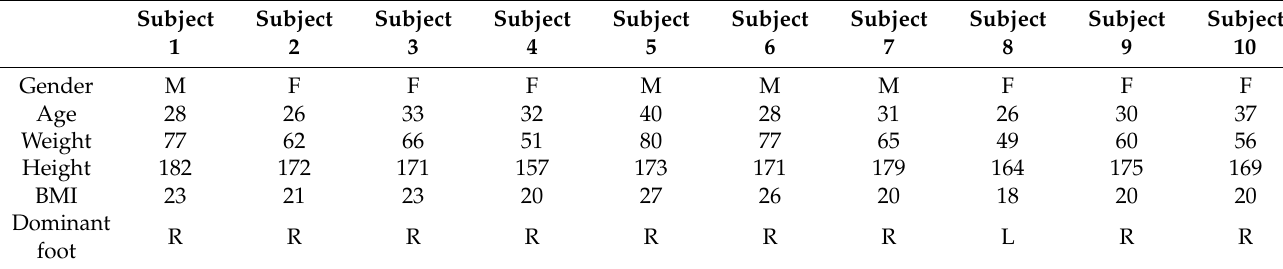
Table 1. Characteristics of the